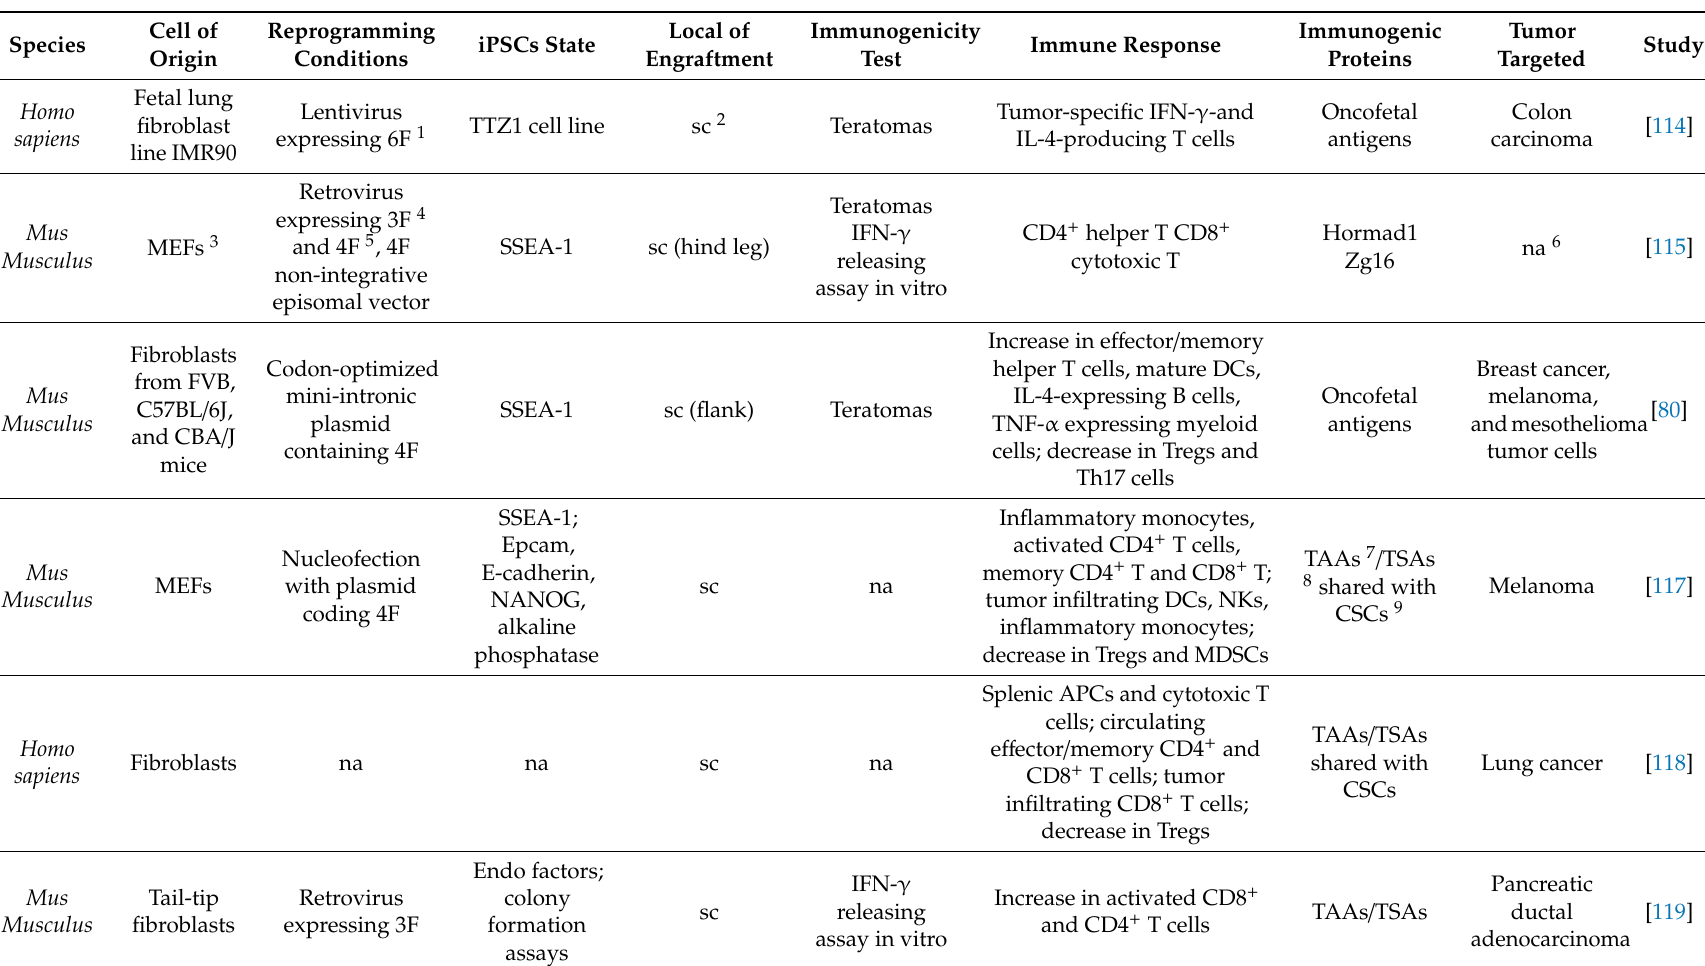
Table 1. Immunogenicity responses elicited by induced pluripotent stem cells (iPSCs) whole-cell cancer vaccines in mouse